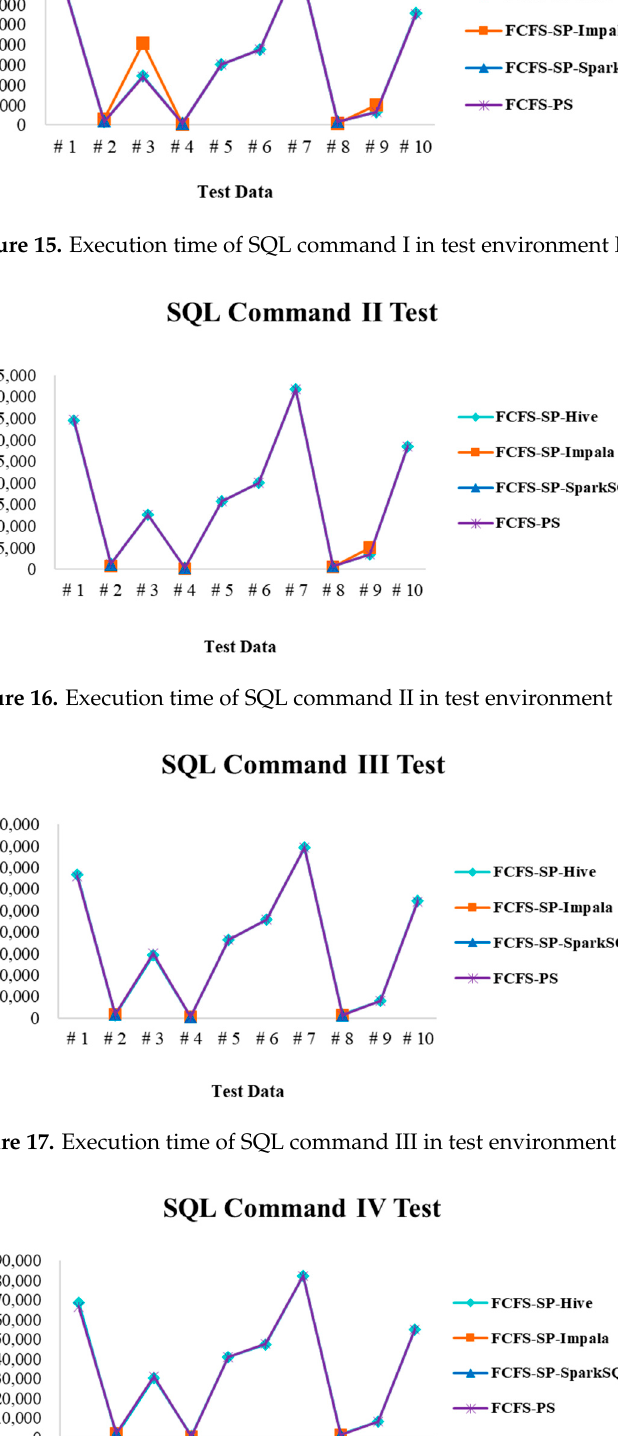
Figure 18. Execution time of SQL command IV in test environment I.